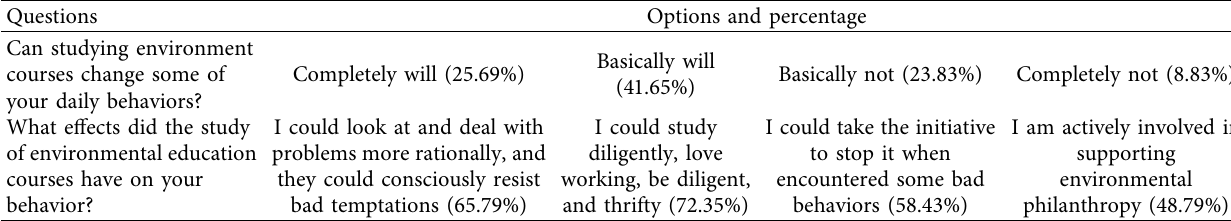
Table 7: College students’ sense of behavior